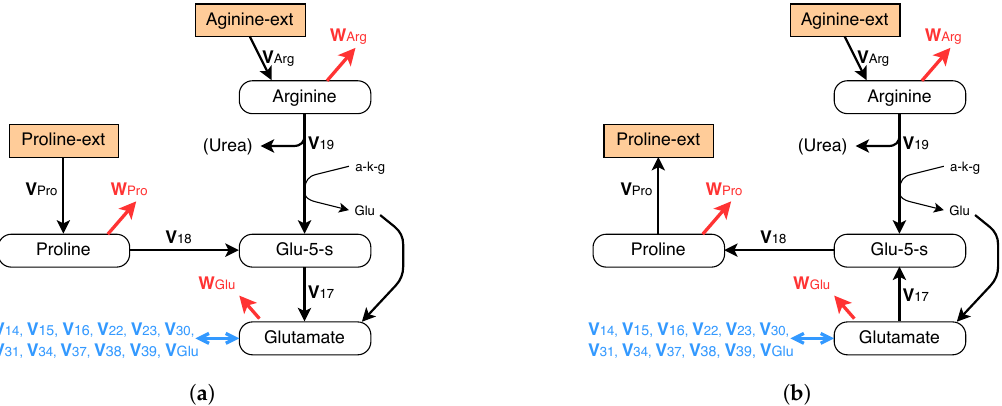
Figure 7. Metabolic network for arginine (essential) and proline (non-essential). ( a ) Exponential growth; ( b ) growth without